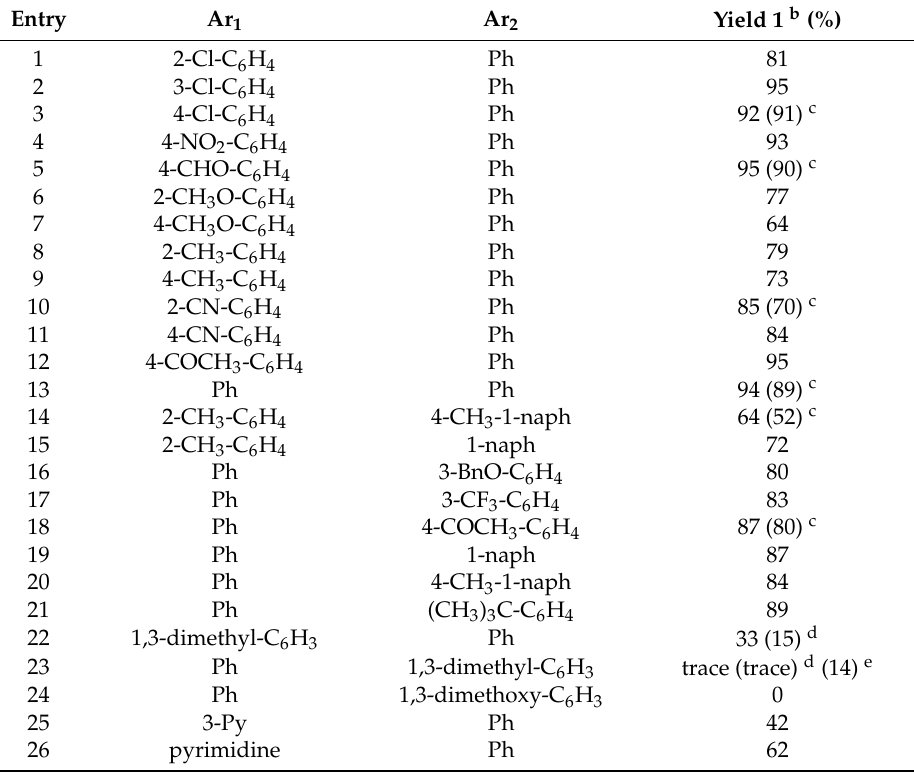
Table 2. Substrate scope in the Suzuki–Miyaura coupling catalyzed by C2 a